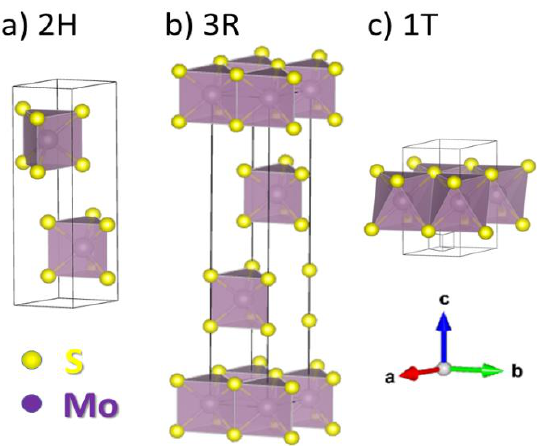
Figure 1. Crystalline structures of the MoS 2 polymorphs. Each MoS 2 layer is a stack comprising an S plane on a Mo plane on yet another S plane. ( a ) The most common 2H polymorphic structure with a hexagonal symmetry, two layers per repeat unit and Mo trigonal prismatic coordination; ( b ) 3R structure with rhombohedral symmetry, three layers per repeat unit and Mo trigonal prismatic co- ordination; ( c ) 1T structure with tetragonal symmetry, one layer per repeat unit and Mo octahedral coordination (same as in the most stable oxides and molybdates). The lattice constant “a” is 0.31 nm